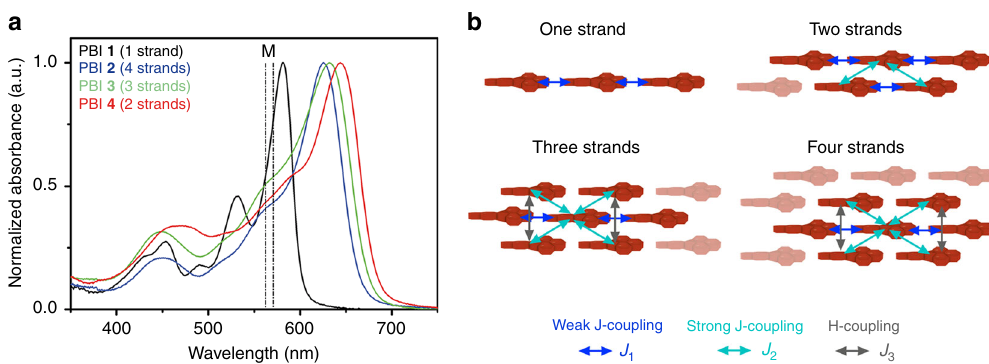
Fig. 5 Solid state UV – vis spectra and exciton coupling schemes of the PBIs 1 – 4 . a Normalized UV – vis absorption spectra of PBIs 1 (black), 2 (blue), 3 (green), and 4 (red) in the solid state drop-casted from CHCl 3 solution are represented as solid lines ( 1 : Cr; 2 , 3 , 4 : LC, c 0 ~ 10 − 4 M) while the two vertical dashed lines indicate the position of the absorption maxima ( λ max ) of their respective monomers in CH 2 Cl 2 solution. b Schematic illustration of proposed J- and H-couplings between next neighbors in multi-stranded assemblies. Blue arrows indicate weak J-coupling ( J 1 ), cyan arrows strong J-coupling ( J 2 ), and gray arrows H-coupling ( J 3 ) between